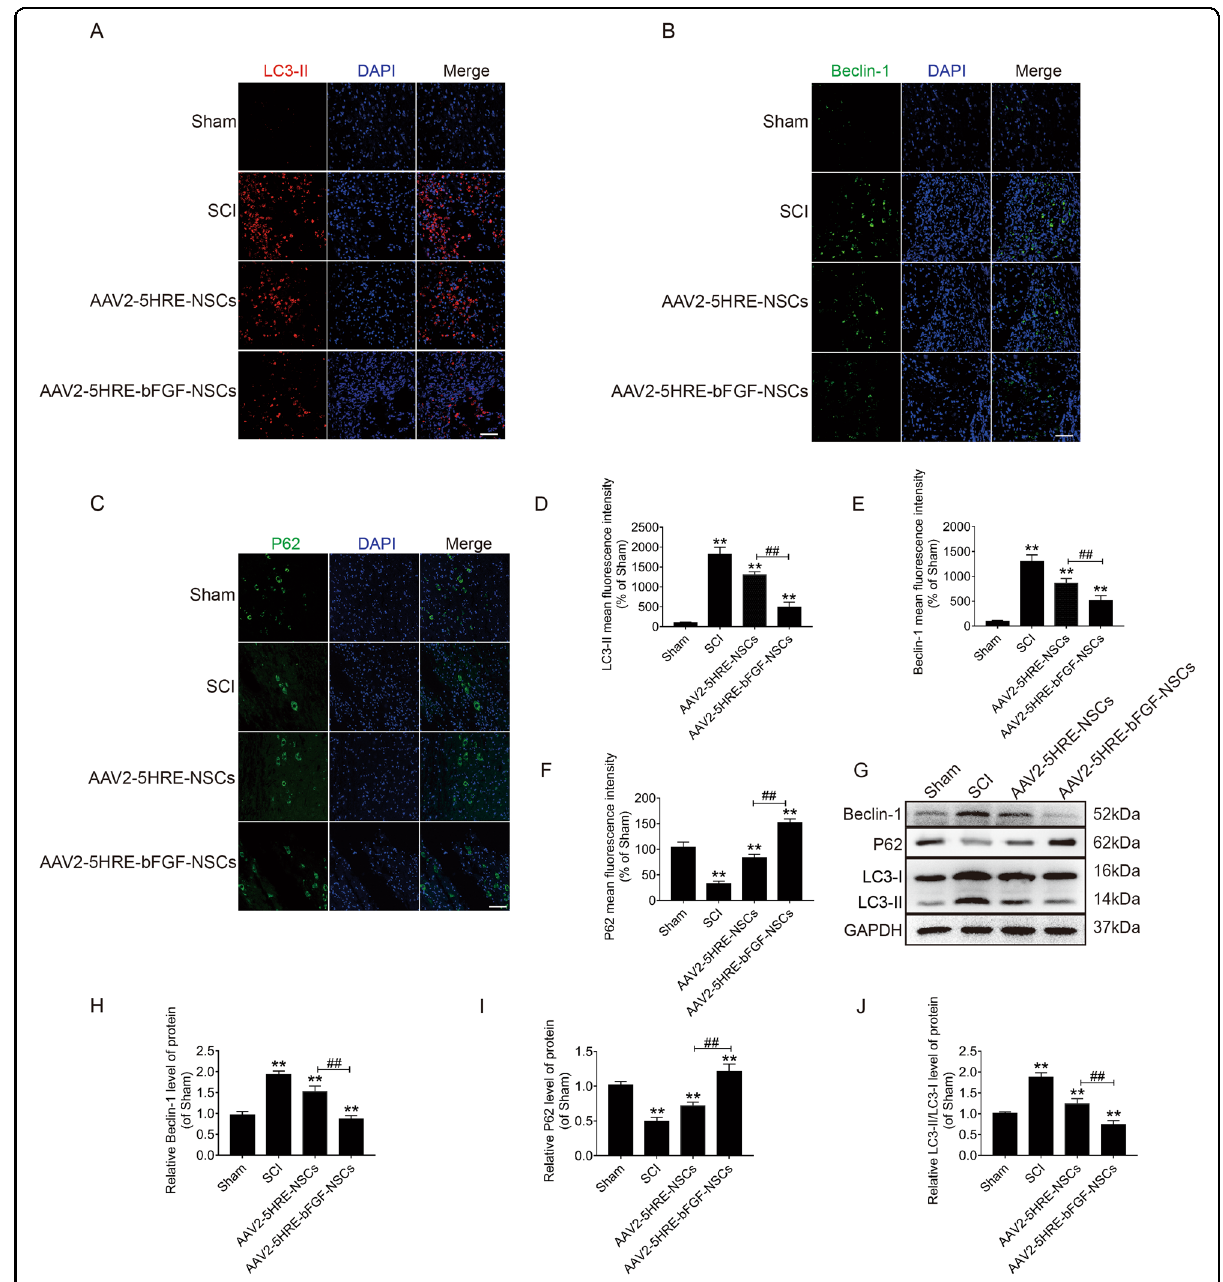
Fig. 7 AAV2-5HRE-bFGF-NSCs show reduced expression of LC3-II and Beclin 1, and augmented expression of P62 proteins in SCI rats. A , B , C Immuno fl uorescence staining of LC3-II, Beclin 1 and P62 in sham group, SCI group, AAV2-5HRE-NSCs group, and AAV2-5HRE-bFGF-NSCs group. The nuclear is stained with DAPI (blue). Scale bar = 50 µm. D , E , F Quantitative analyses of fl uorescence intensity results. G Western blotting results of Beclin 1, P62, and LC-3 expression levels. GAPDH was used as an internal reference. Quantitative analyses of Western blots of Beclin 1 ( H ), P62 ( I ), LC3 ( J ) are presented. “ ** ” represents P < 0.01, versus the sham group or SCI group. “ ## ” represents P < 0.01, versus the AAV2-5HRE-NSCs group. Data are the mean values± SEM ( n =